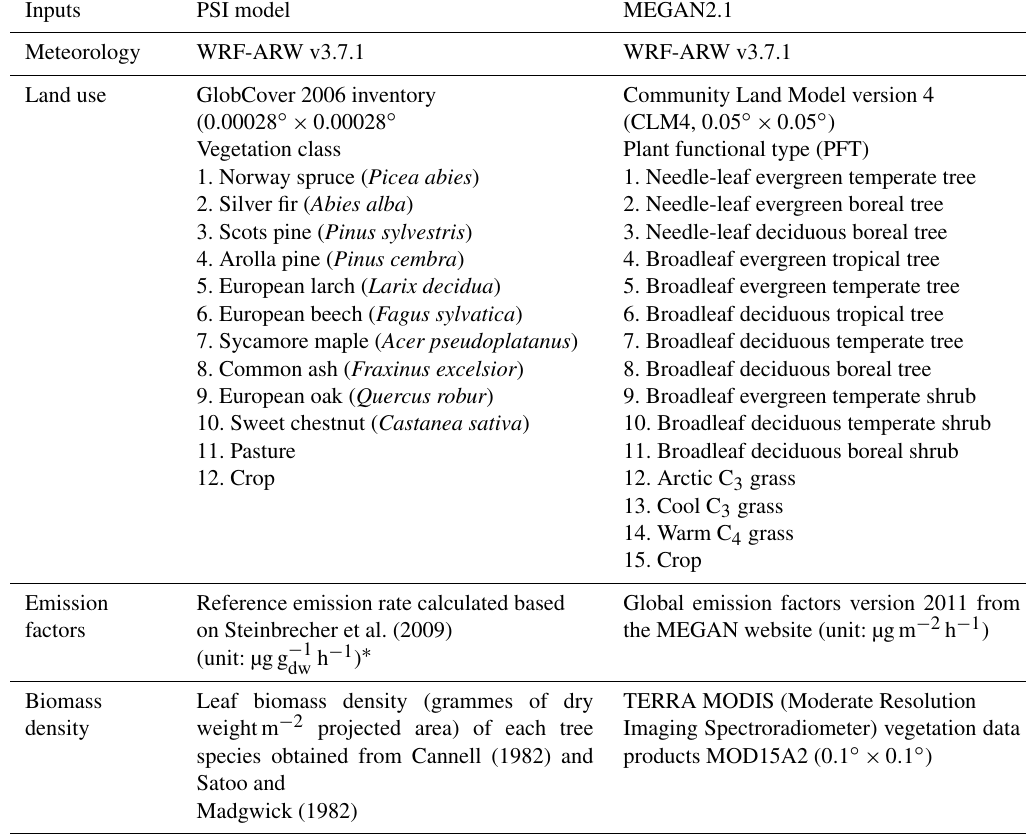
Table 1. Comparison between the major input of the PSI model and MEGAN version 2.1.